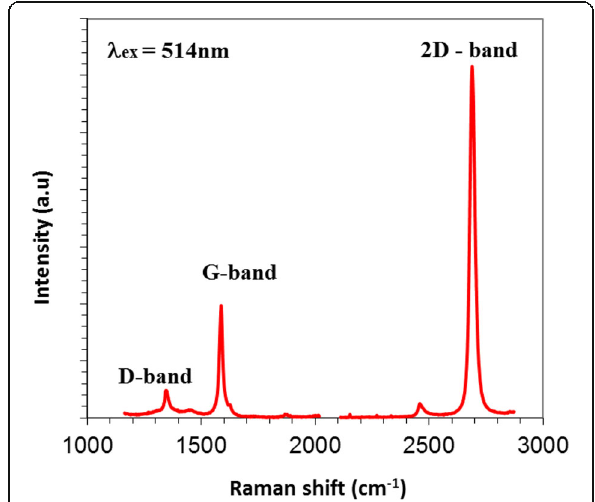
Fig. 1 Single point Raman scattering spectrum (514-nm excitation) from which we infer the transfer of single layer graphene on the Si waveguide devices studied here as a result of the intense, symmetric 2D scattering mode and G peak frequency,